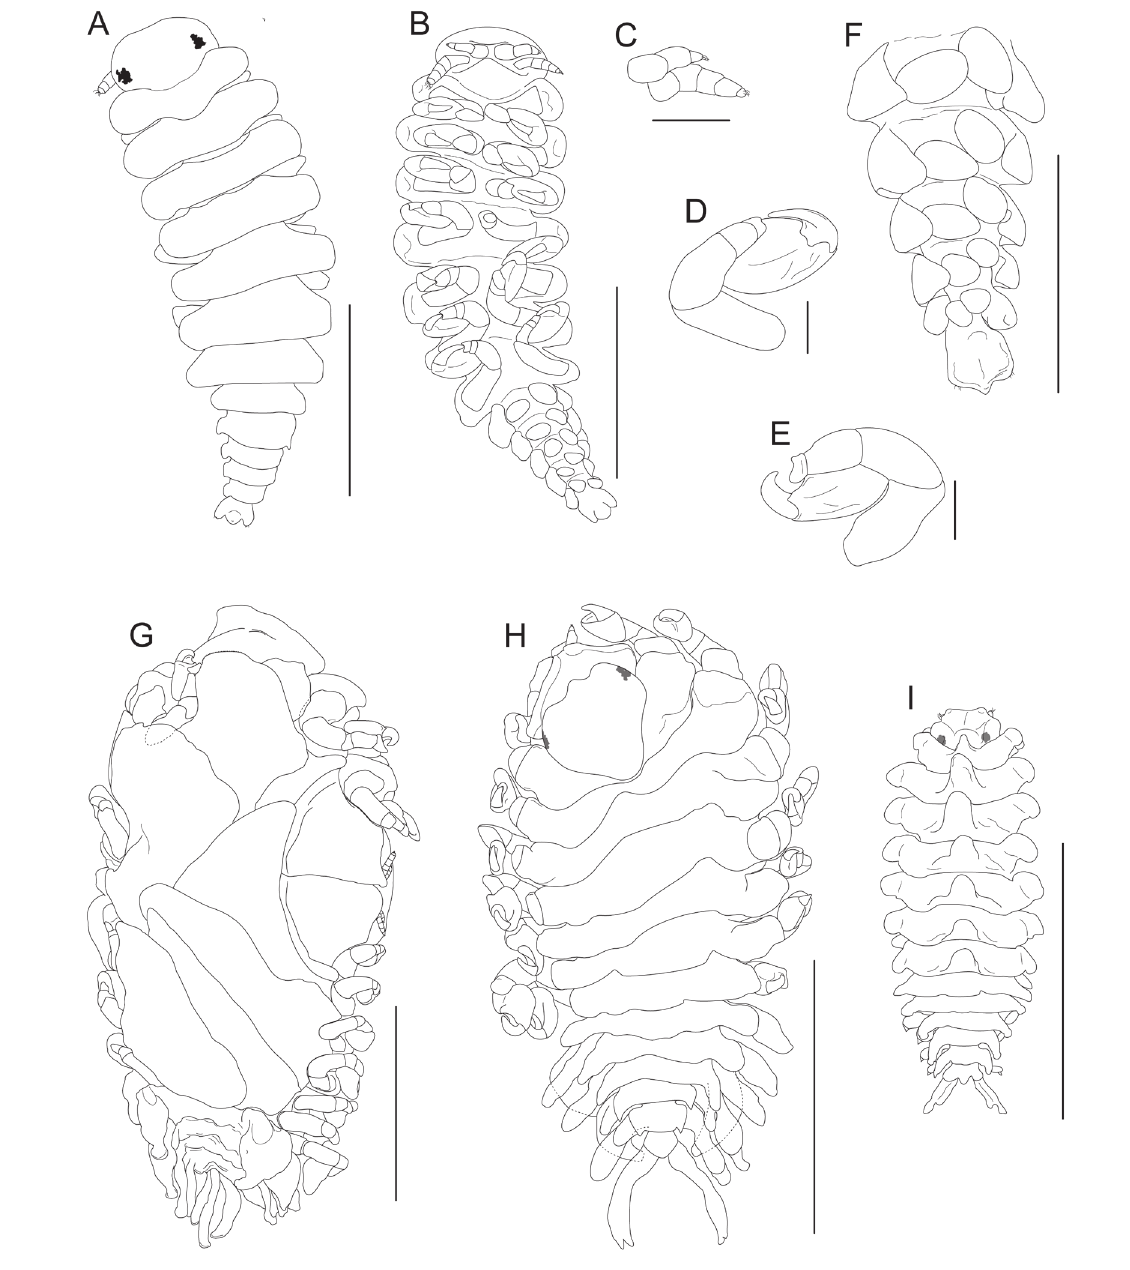
Fig. 8. Asymmetrione tuxtlaensis sp. nov. A . Dorsal view, holotype ♂ (CNCR-36493-A). B . Ventral view. C . Antennule and antennae ♂. D . First right pereopod of ♂, paratype (CNCR-36495). E . Seventh left pereopod of same ♂ paratype. F . Pleon of same ♂ paratype, ventral view. G . Adult ♀, paratype (CNCR-36499), ventral view. H . Juvenile ♀ (CNCR-36498-A), dorsal view. I . Bopyridium (CNCR- 36492-B), dorsal view. Scale bars: A–B, G–I = 1.0 mm; C–E = 0.1 mm; F = 0.5